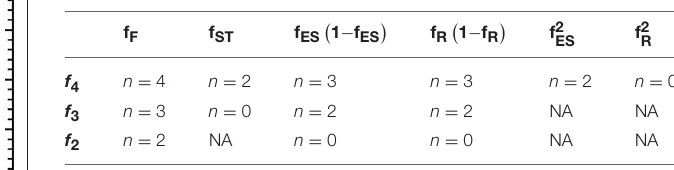
TABLE 2 | Coarse-grained connectivity of 13 allowed configurations found in alkali silicate glass networks with < 40 mol% alkali oxide as discussed in the